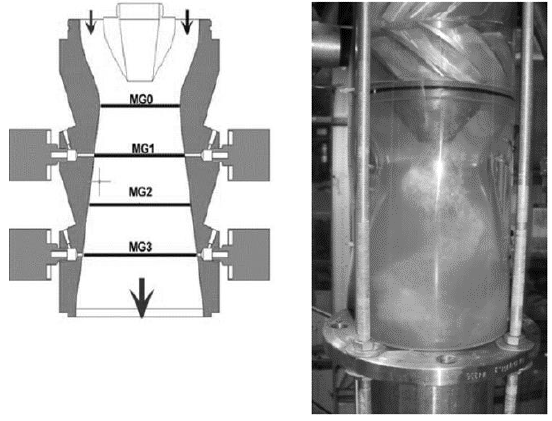
Fig. 5. Locations of pressure probes (left) and visualization of the vortex rope (right) [5]